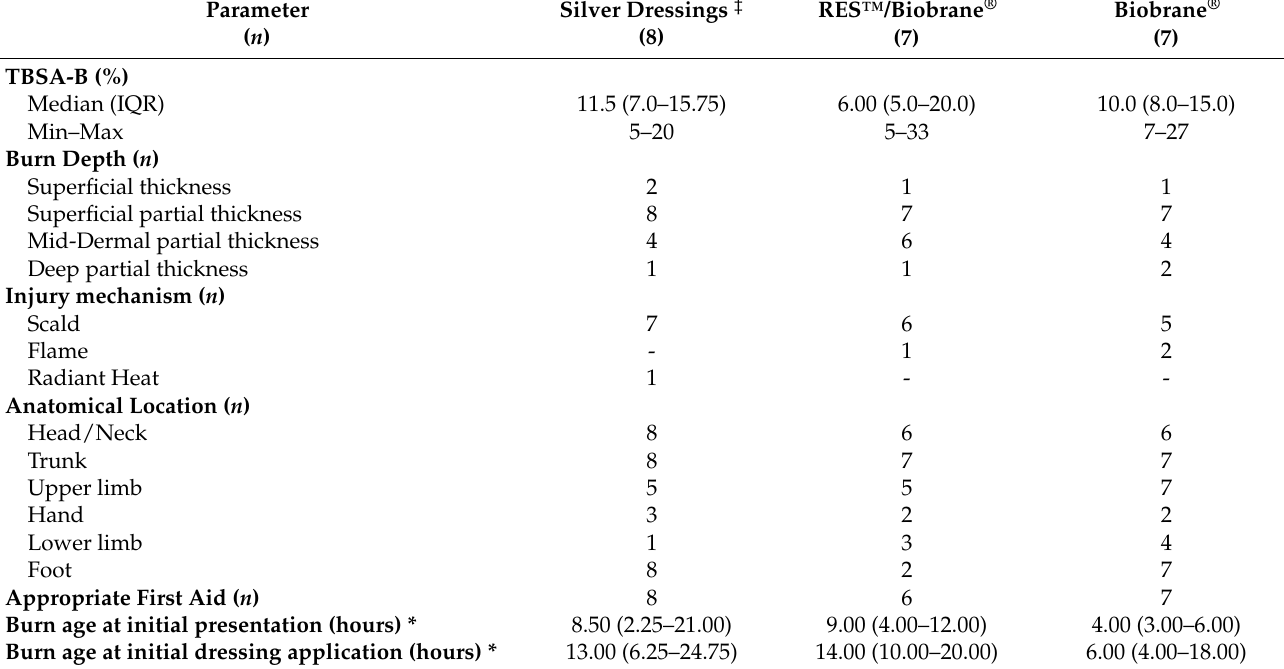
Table 2. Baseline burn wound